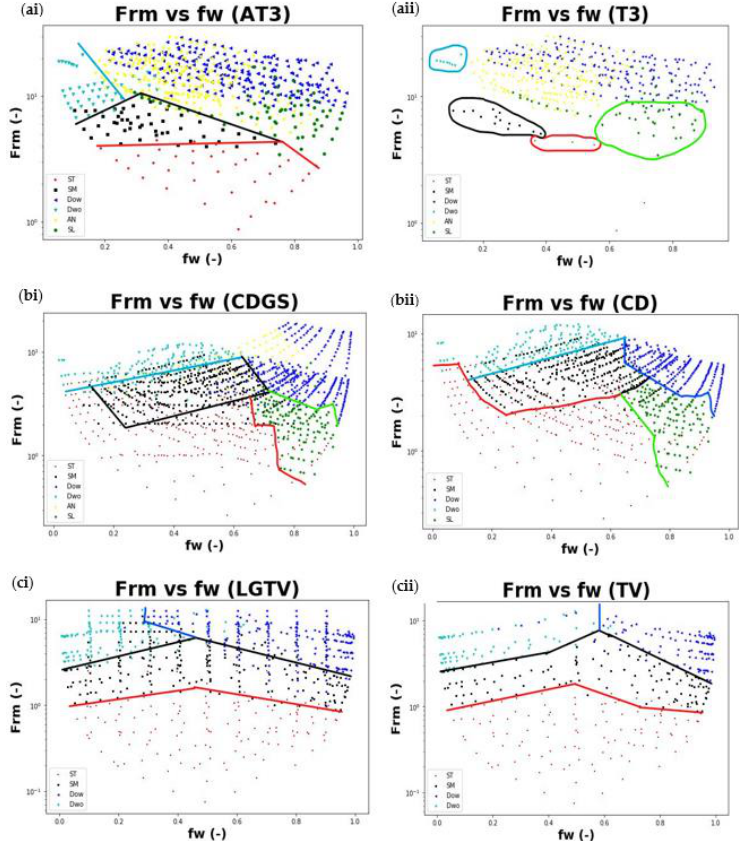
Figure 8. The mixture Froude number Fr m versus water fraction f w , ( ai ) class 1, ( aii ) class 1 with experimental work of a diameter 14.5 mm, ( bi ) class 2, ( bii ) class 2 with experimental works of diameters 25 and 25.4 mm, ( ci ) class 3, ( cii ) class 3 with experimental works of diameters 50.1 and 50.8 mm, for the gathered published experimental datasets. Note: data points denoted with red squares, black rectangles, blue triangle_left, cyan triangle_down, yellow circle and green star represent stratified flow (ST), stratified mixed flow (SM), dispersed oil-in-water flow (Do/w), dispersed water-in-oil flow (Dw/o), annular flow (AN) and slug flow (SL), respectively. Each boundary line denotes with red, black, blue, cyan and green encloses—partially or completely—stratified flow (ST), stratified mixed flow (SM), dispersed oil-in-water flow (Do/w), dispersed water-in-oil flow (Dw/o) and slug flow (SL), respectively. The combinations of dimensionless groups used for the analysis are (i) Re m /Eo versus f w , (ii) We/Eo versus f w , (iii) Fr m versus f w , (iv) G/V versus f w , (v) Fr w versus Fr o . Let Fr m versus f w be a representative combination of dimensionless groups to show the effect of pipe diameters on the liquid-liquid flow pattern in the horizontal pipeline, as presented in Figure 8. The experimental works in class 1 are those of